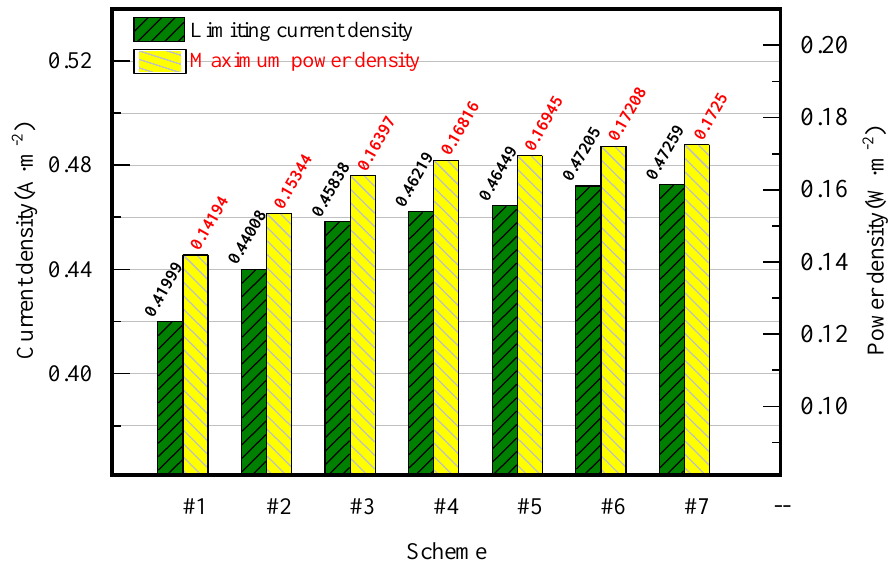
Figure 12. The limiting current density and the maximum power density between schemes #1 and